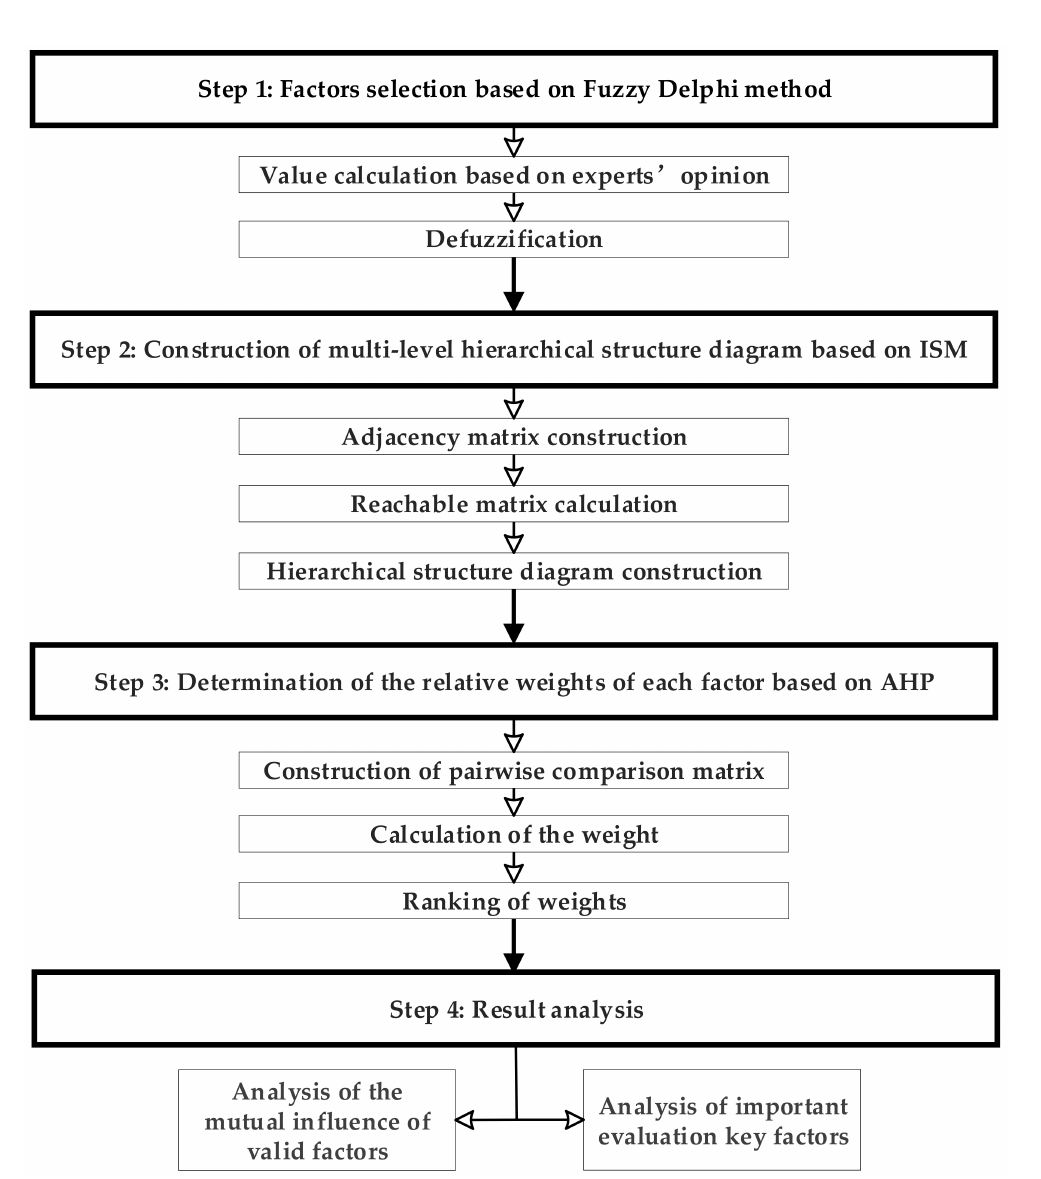
Figure 1. Factor analysis of urban community resilience based on interpretative structural model–analytic hierarchy process